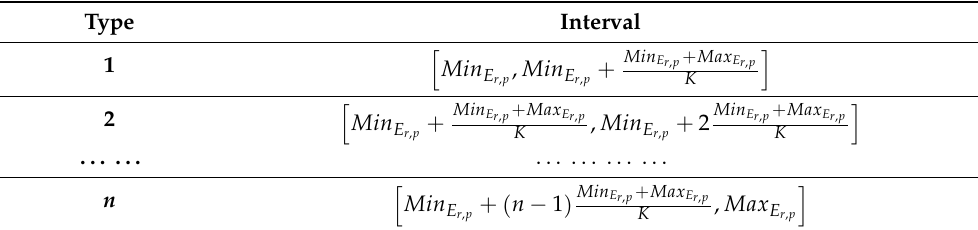
Table 3. VAT splitting